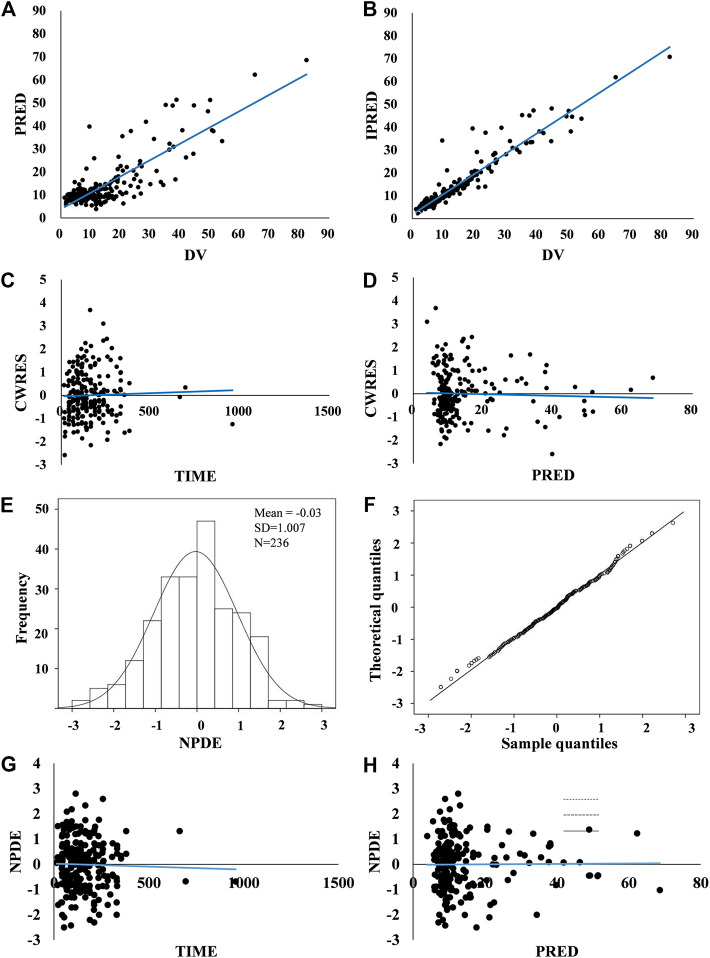
Model evaluation. (A,B) Routine diagnostic goodness-of-fit plots: population predicted (PRED) vs. observed concentrations (DV) and individual predicted (IPRED) vs. observed concentrations (DV). (C,D) Conditional weighted residuals (CWRES) vs. time and conditional weighted residuals (CWRES) vs. population predicted concentrations (PRED). A solid blue line indicates a trend line. Standard goodness-of-fit of the model showed no obvious systematic bias. There were no trends in conditional weighted residuals distributions. (E–H) Normalized prediction distribution errors (NPDE): Q-Q plot of the distribution of the NPDE vs. the theoretical N–(0, 1) distribution and a histogram of the distribution of the NPDE, with the density of the standard Gaussian distribution overlaid. NPDE distribution with the mean of 0.03 met well the theoretical N – (0, 1) distribution, and no trend in the scatterplots was observed, indicating that the fit of the model to the data was acceptable.